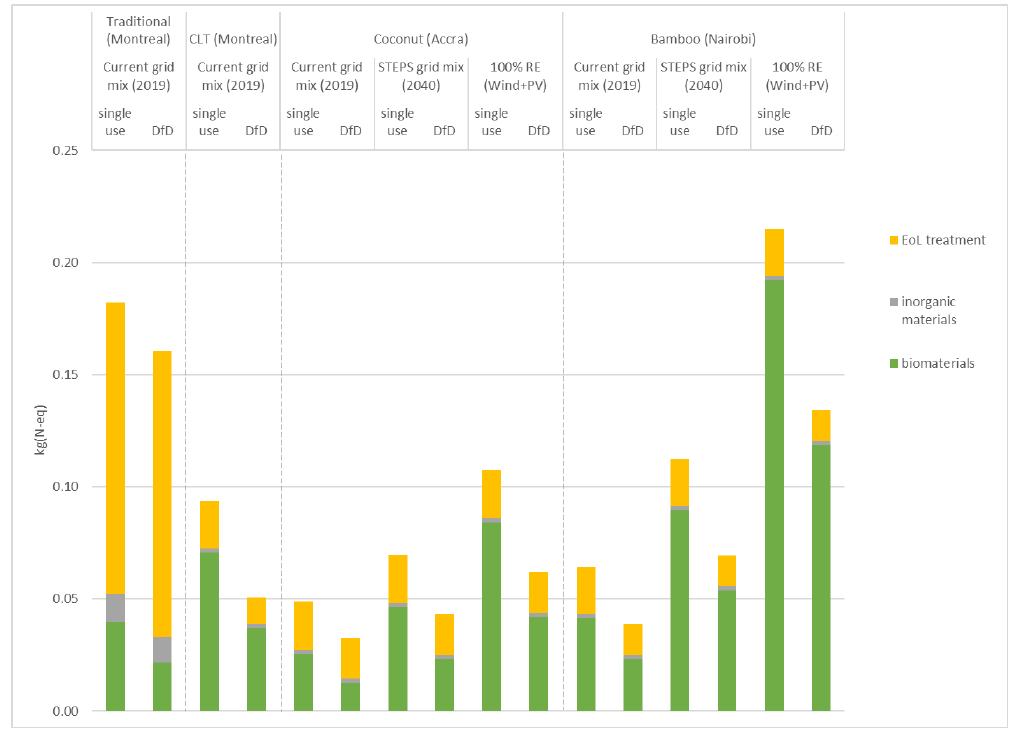
Figure 8. Eutrophication potential results for the three wall assemblies and locations, with sensitiv- ity analyses (FU = 1 m 2 ). analyses (FU = 1 m 2 ).